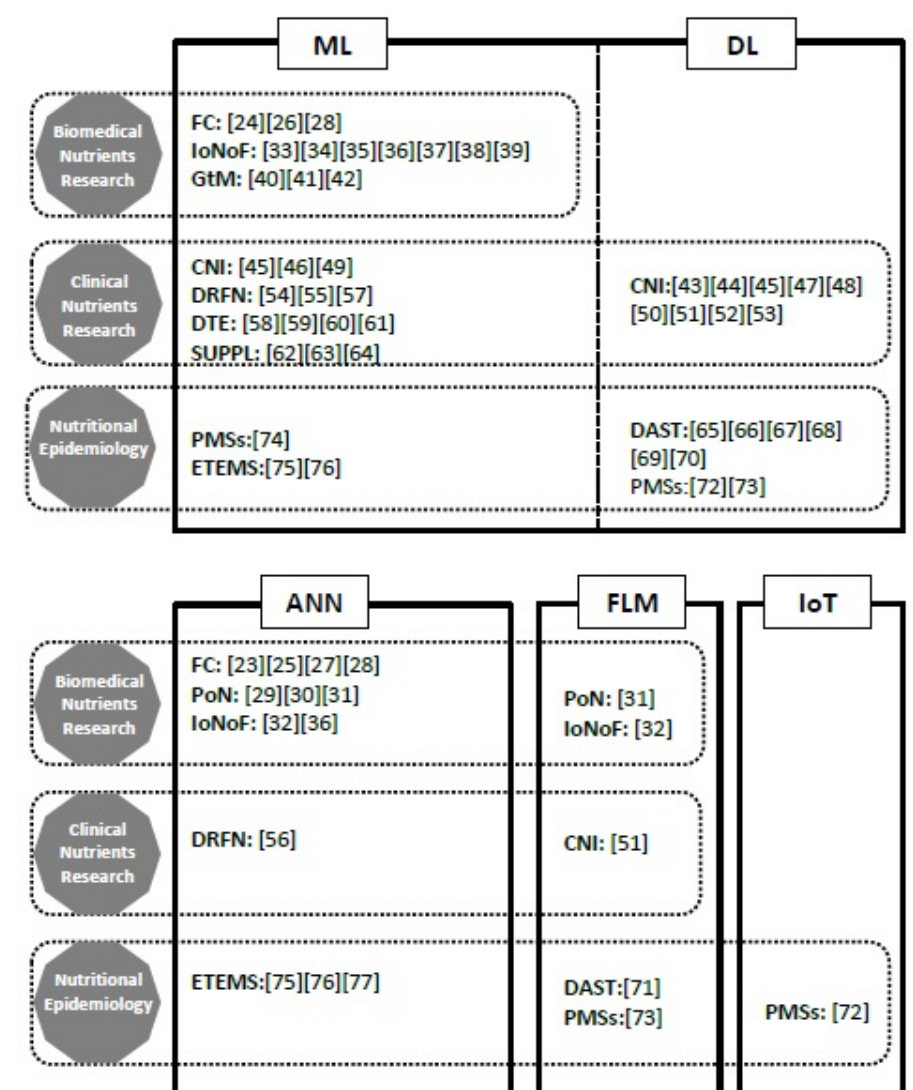
Figure 2. The studies of nutrients science research in relation to artificial intelligence (AI) domains. Note: AI do- mains: ML = machine learning, DL = deep learning, ANN = artificial neural network, FLM = fuzzy logic methodology, IoT = Internet of Things; biomedical nutrients research: FC = food composition; PoN = production of nutrients; IoNoF = in- fluence of nutrients on phys./path. functions; GtM= gut microbiota; clinical nutrients research: CNI = clinical nutrients intake; DRFN= diseases risks to food and nutrients patterns; DTE = disease and trace elements levels; SUPPL = supplementa- tions; nutritional epidemiology: DAST = dietary assessment; PMSs = physical monitoring systems; ETEMS = environmental trace elements monitoring systems, [...] =